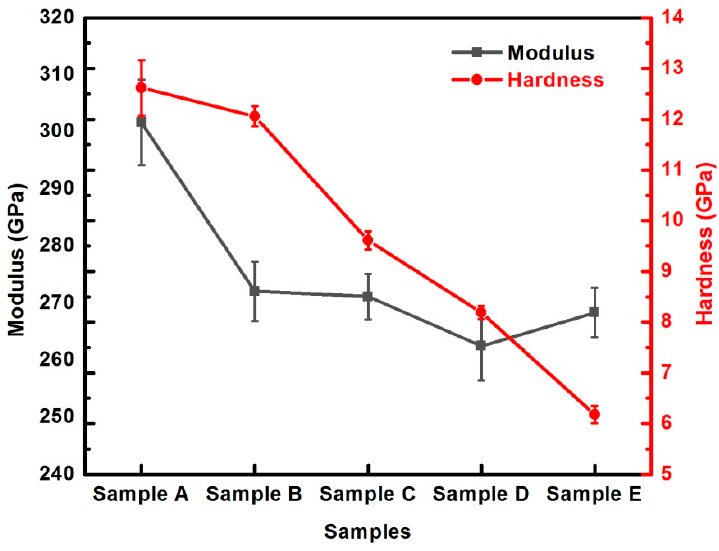
Figure 6. Hardness and elastic modulus of different printed samples.